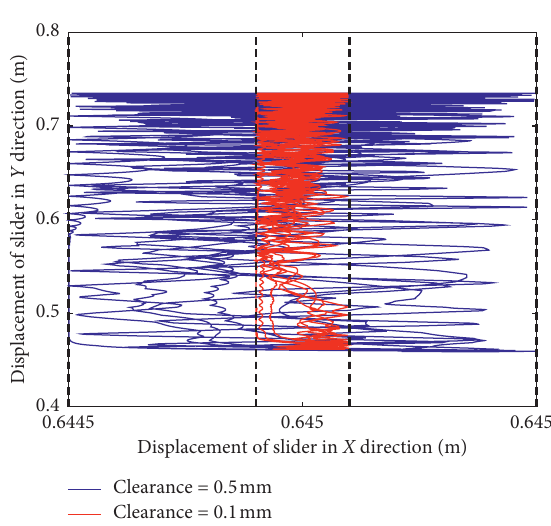
Figure 15: Slider trajectory inside the